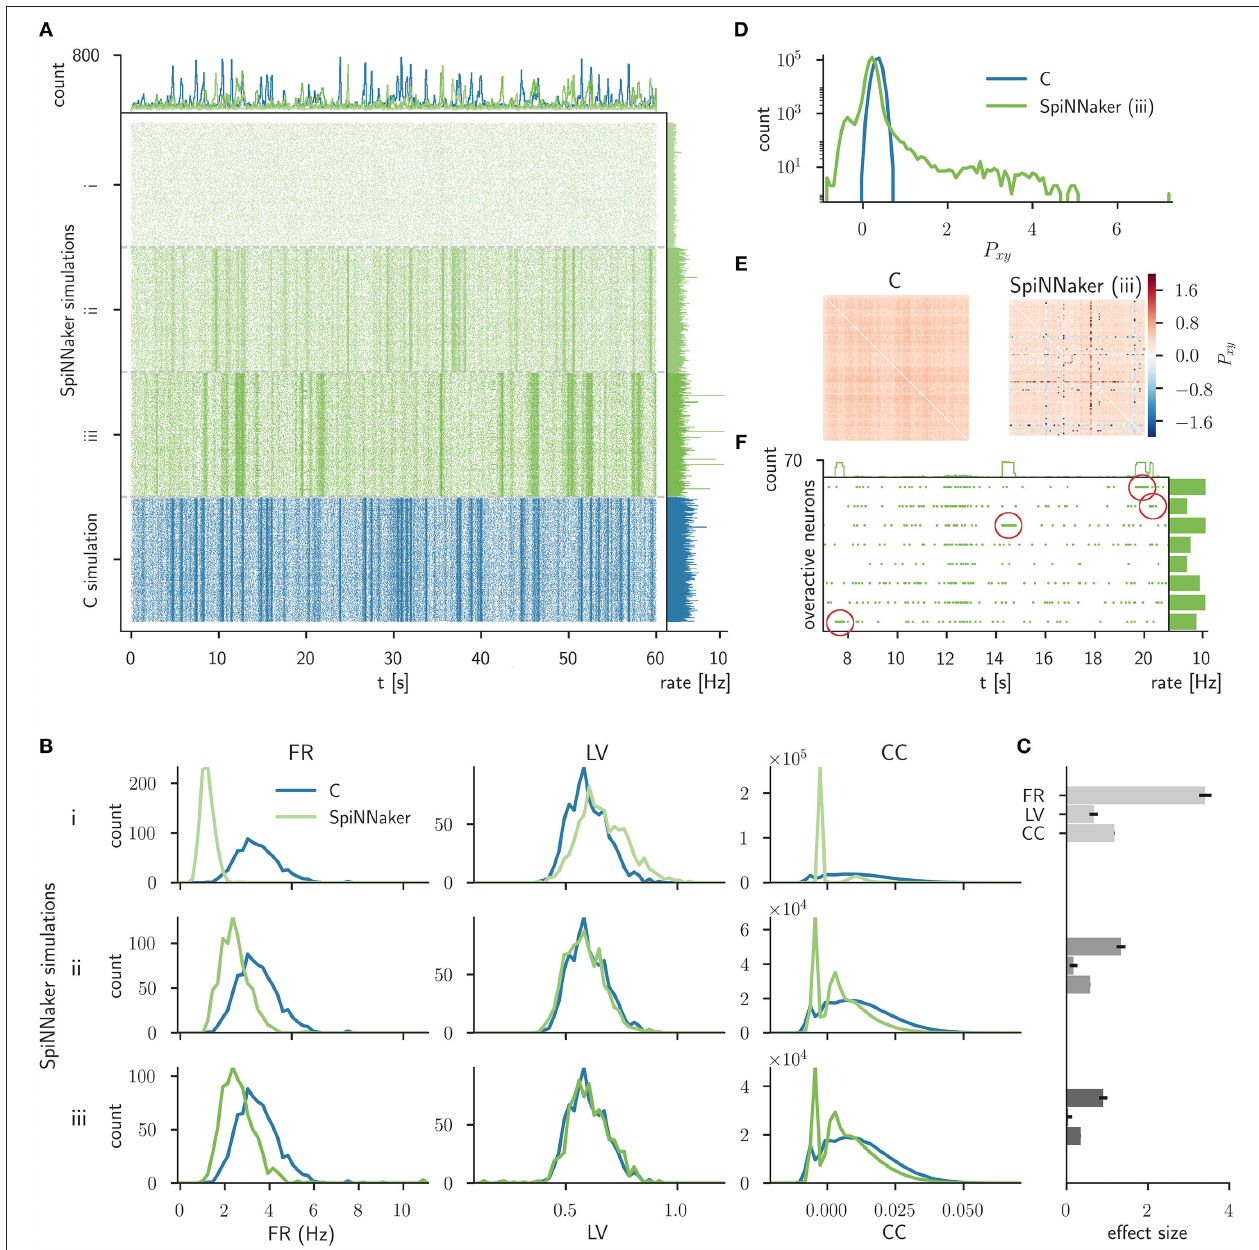
FIGURE 5 | Comparison of the C simulation with simulations of three consecutive stages of the SpiNNaker implementation. (A) Raster plot of the spiking network activity (800 excitatory neurons) of the C simulation (bottom, blue) and three stages of the SpiNNaker implementation; i, ii, and iii (top, shades of green). The top and right histograms show the population spike counts in 60 ms bins and the mean firing rates, respectively. (B) Distributions of firing rates (FR, left), local coefficients of variation (LV, middle), and correlation coefficients (CC, right) for the C and SpiNNaker simulations. Each row (subsequent implementation steps: i, ii, iii) represents a specific SpiNNaker simulation (green) that differs in the underlying neuron model implementation. Data shown for the C simulation (blue) are identical in the three rows. (C) The difference between the distributions is quantified by the effect size with error bars indicating the 95% confidence interval. In step iii the effect sizes for the FR, LV, and CC measure are 0.90, 0.05, and 0.36, respectively. (D) Distributions of the sum of the cross-correlation coefficient ( P xy , Equation 7) in logarithmic representation for C and SpiNNaker (implementation step iii). (E) Color coded correlation matrices for the sum of the cross-correlation coefficient in implementation step iii. The symmetric matrices display results for the subset of 100 excitatory neurons with highest spike rates in the SpiNNaker simulation. (F) Raster plot of 8 overactive neurons in the SpiNNaker simulation (implementation step iii) showing episodes of 1 kHz spiking (emphasized by red markers). The top and right histograms show the population spike counts in 60 ms bins and the mean firing rates for the entire recording, respectively.